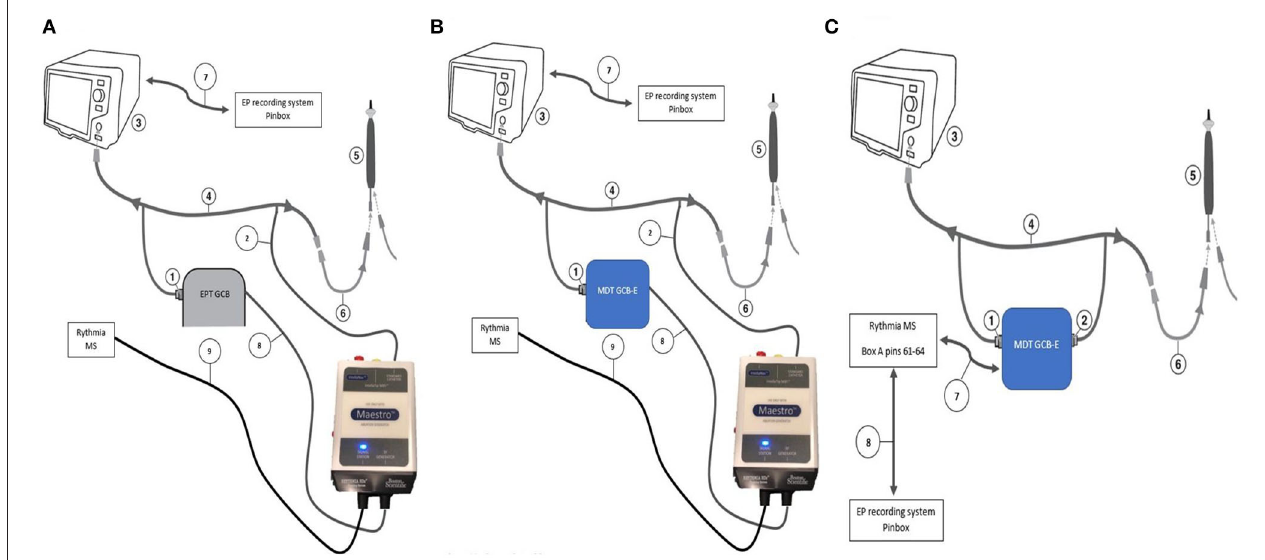
FIGURE 1 | DiamondTemp and Rhythmia connectivity configurations. (A) Setup 3.1. An EPT GCB and Rhythmia Maestro GCB (Maestro GCB, native Rhythmia setup). (1) 14-pin twist connector to RFG via the GCC; (2) 9-pin quick connector to DTC via the GCC to the DTC to RFG cable; (3) DTA RFG; (4) DTA GCC; (5) DTC; (6) DTC to RFG cable; (7) IC out cable; (8) 9-pin quick connector of the Maestro GCB; and (9) Connector from the Maestro GCB to the Rhythmia MS. (B) Setup 3.2. This configuration shows the best accuracy results—The catheter connection is connected to Rhythmia GCB using Genconnect cable and then to MDT GCB as shown in the picture. (1) 14-pin twist connector to RFG via the GCC; (2) 9-pin quick connector to DTC via the GCC to the DTC to RFG cable; (3) DTA RFG; (4) DTA GCC; (5) DTC; (6) DTC to RFG cable; (7) IC out cable; (8) 9-pin quick connector of the Maestro GCB; and (9) Connector from the Maestro GCB to the Rhythmia MS. (C) Setup 3.3. The MDT GCB-E and IC out via the MDT GCB-E directly to the Rhythmia IC in at box 1 (pin A61 to A64) (1) 14-pin twist connector to RFG via the GCC; (2) 9-pin quick connector to DTC via the GCC to the DTC to RFG cable; (3) DTA RFG; (4) DTA GCC; (5) DTC; (6) DTC to RFG cable; (7) IC out cable; and (8)Rhythmia IC out to the EP recording